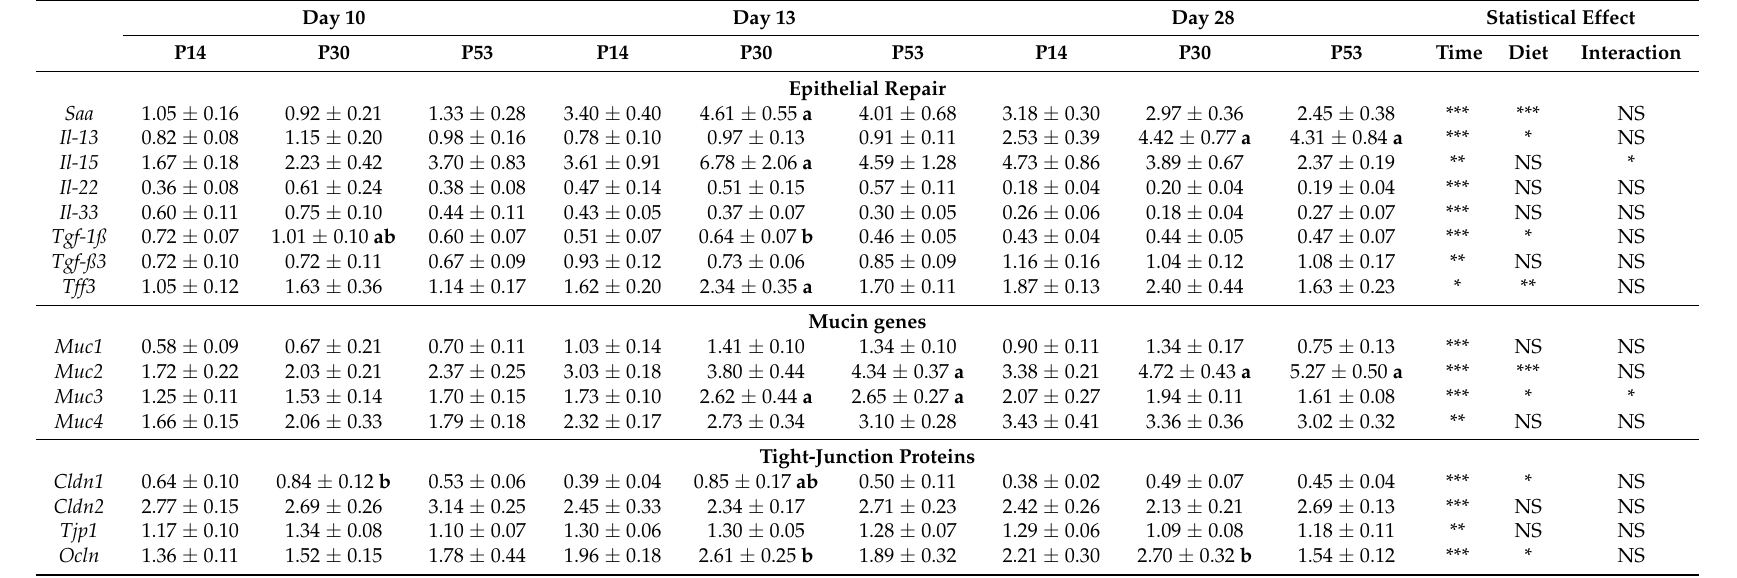
Table 2. Effects of dietary protein intake level on colonic gene expression. Relative expression level of mRNA expressed as was means ± SEM normalized to day 7 group ( n = 10–12). *: p < 0.05; **: p < 0.01; ***: p < 0.001; NS: non-significant difference. a: vs P14, p < 0.05 at the same time, b: vs P53, p < 0.05 at the same